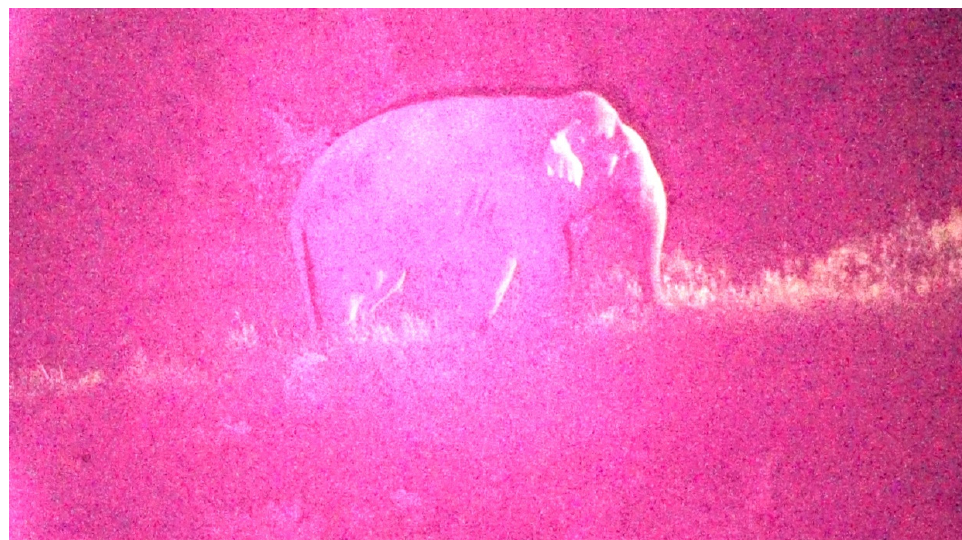
Figure 2. A video still of a bull elephant in a crop field in Kanchanaburi, Thailand. The pink hue is from an infrared camera; the white spotlight is attached to a farmer’s truck and is intended as a deterrent. The sound from the truck’s engine and shouts from the farmers also act as significant aversive stimuli. Video recorded by the authors.